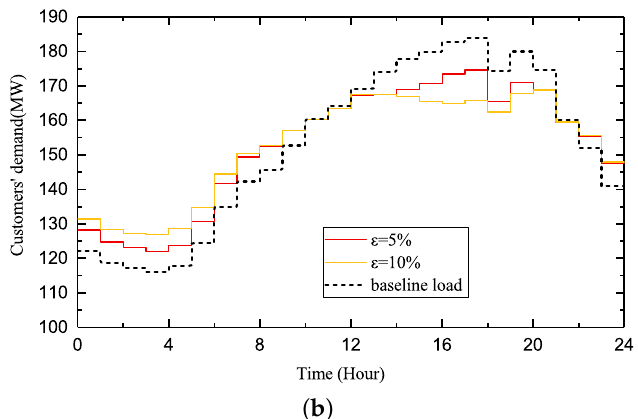
Figure 10. ( a ) SL incentive prices for different load-shift capability ( b ) Customers’ demand for different load-shift